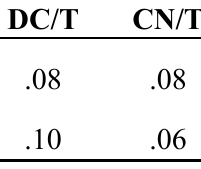
Correlations among Belinda’s topic measures and total complexity and accuracy